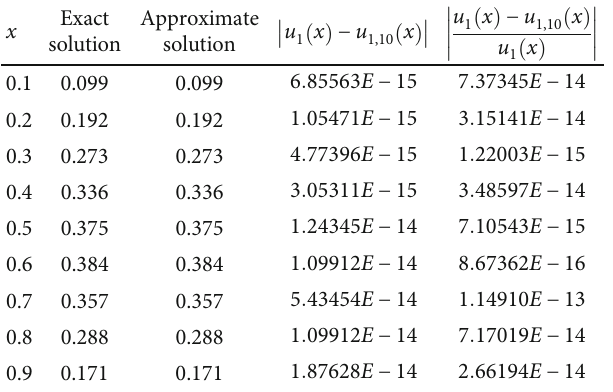
x Þ for Example 2 ð